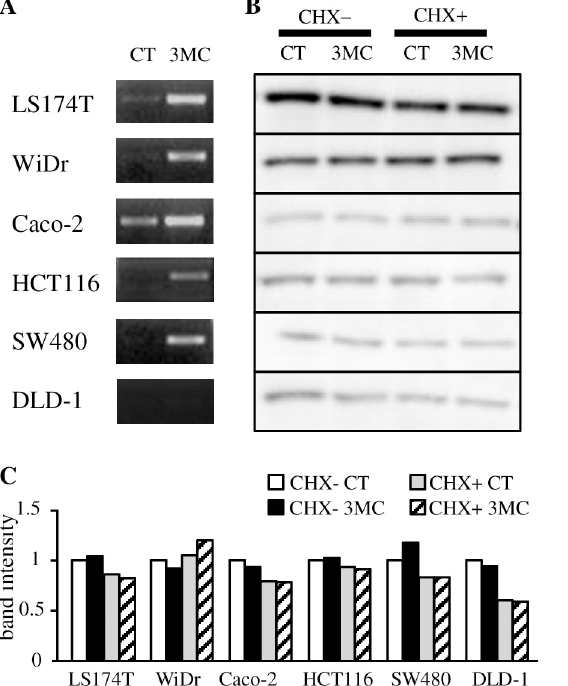
Fig 2. Change in β -catenin levels upon exposure of AhR ligands in various colon tumor cell lines. A) Induction of CYP1A1 mRNA by 3MC (1 μ M) exposure in six colon tumor cell lines were investigated. After 6 hours of 3MC exposure, total RNA was isolated, and CYP1A1 mRNA was detected by semi-quantitative RT-PCR methods. The data showed amplified CYP1A1 cDNA in optimized cycles (24–36 cycles), which indicated marked differences. B) Six colon tumor cell lines were exposed to 3MC (1 µ M) with or without 100 µ M cycloheximide (CHX) serving as the solvent control (CT). After six-hour incubation, cell lysates were extracted and 10 or 20 µ g of protein were subjected to western blotting with β -catenin antibodies. Representative blots are shown. C) Graph shows relative amount of β - catenin expression compared to control in each cell line. Bars represent the mean of duplicate determinations.